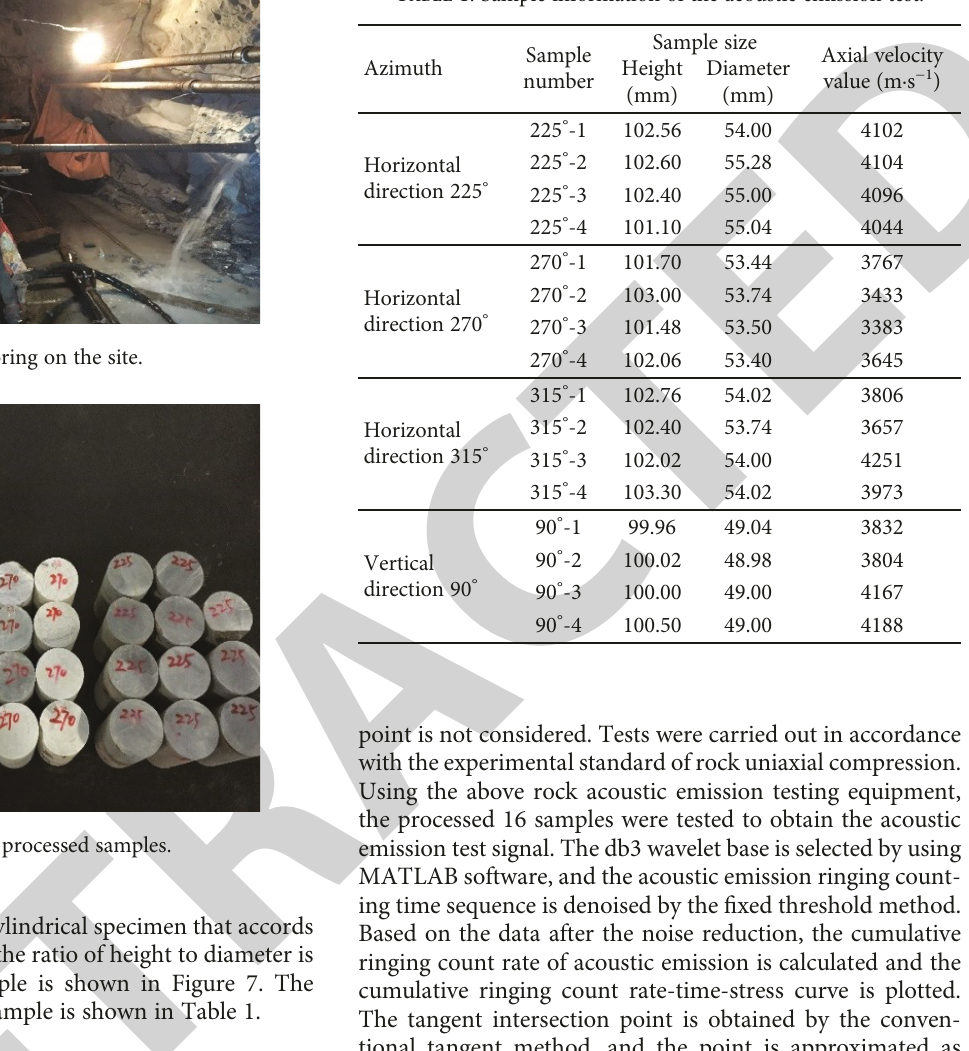
Table 1: Sample information of the acoustic emission